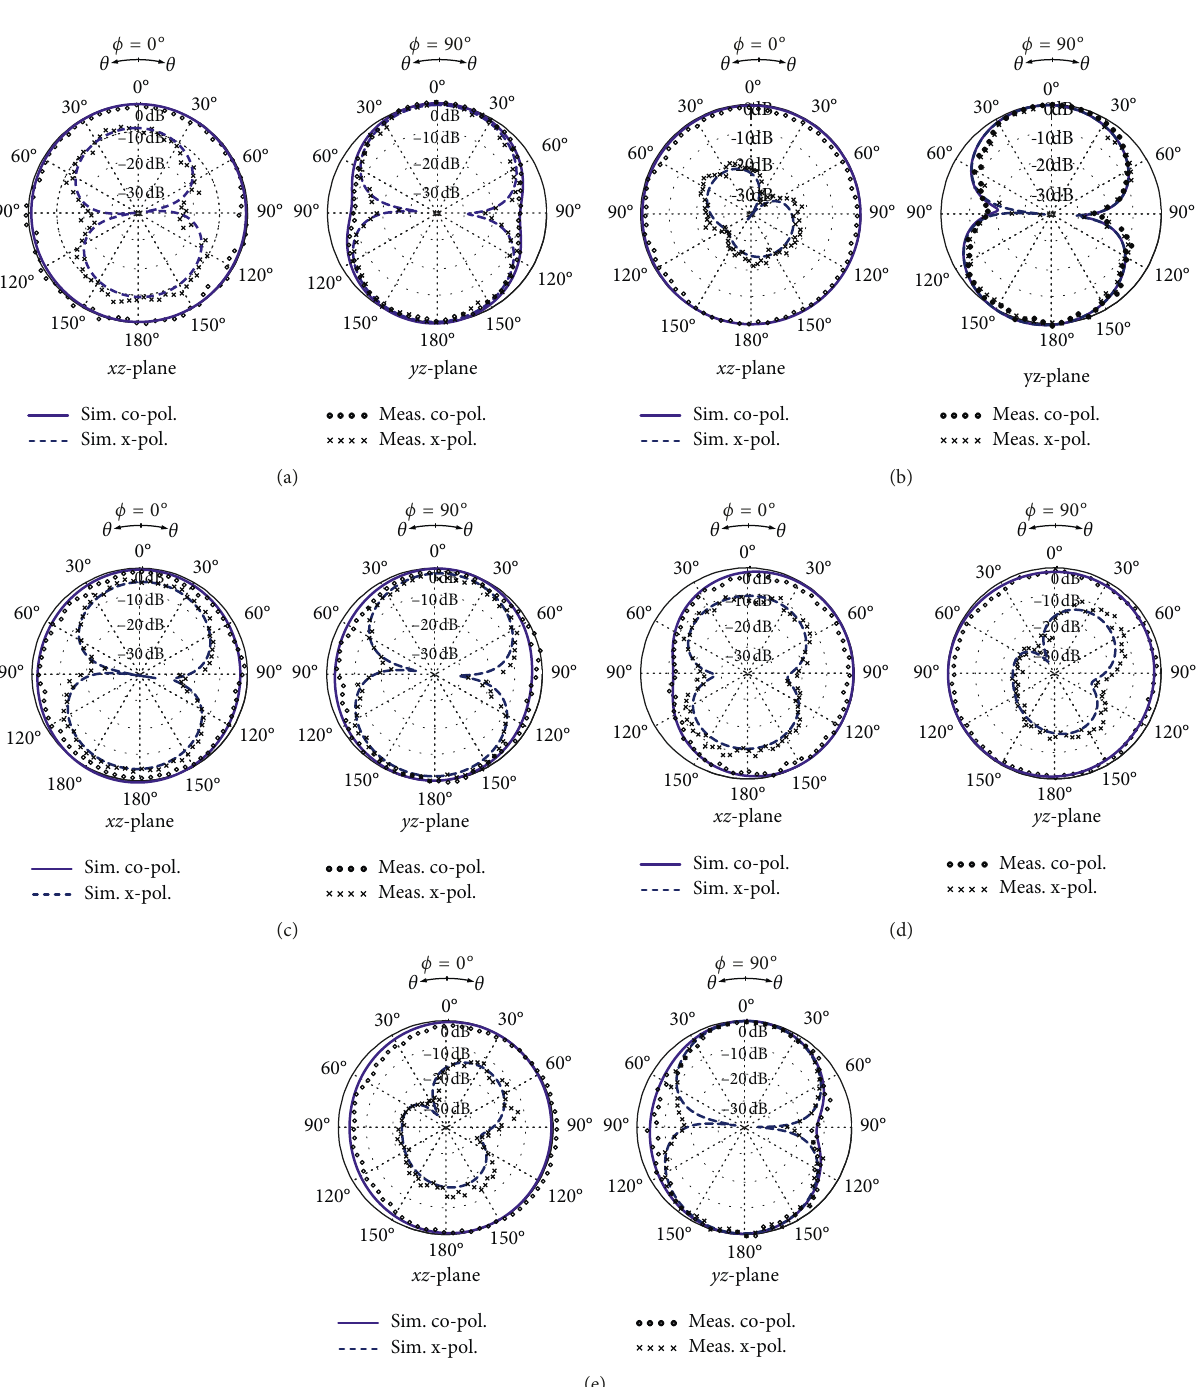
Figure 12: Simulated and measured radiation pattern of the WLAN/WiMAX triband antenna at (a) 2.4, (b) 3.5, (c) 5.2, (d) 5.5, and (e)